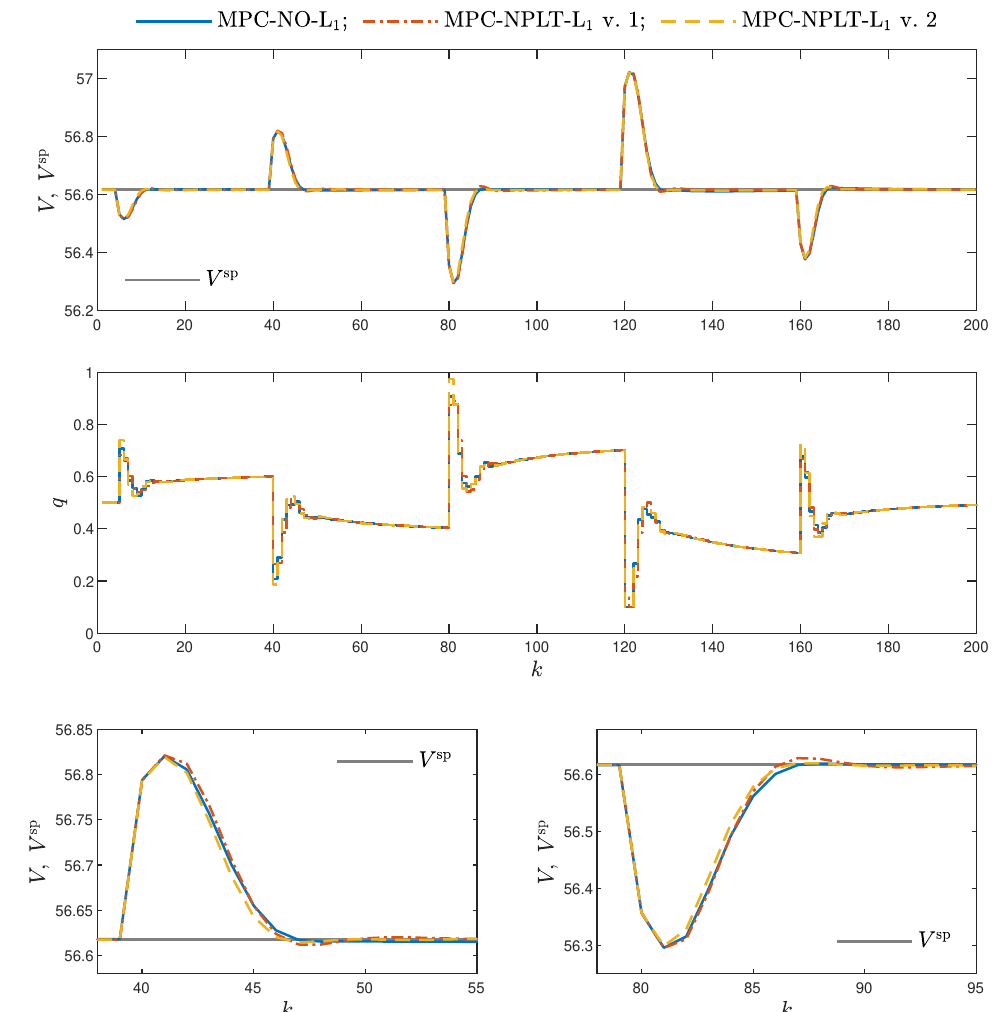
Figure 5. Simulation results: the MPC-NO-L 1 , MPC-NPLT-L 1 v. 1 and MPC-NPLT-L 1 v. 2